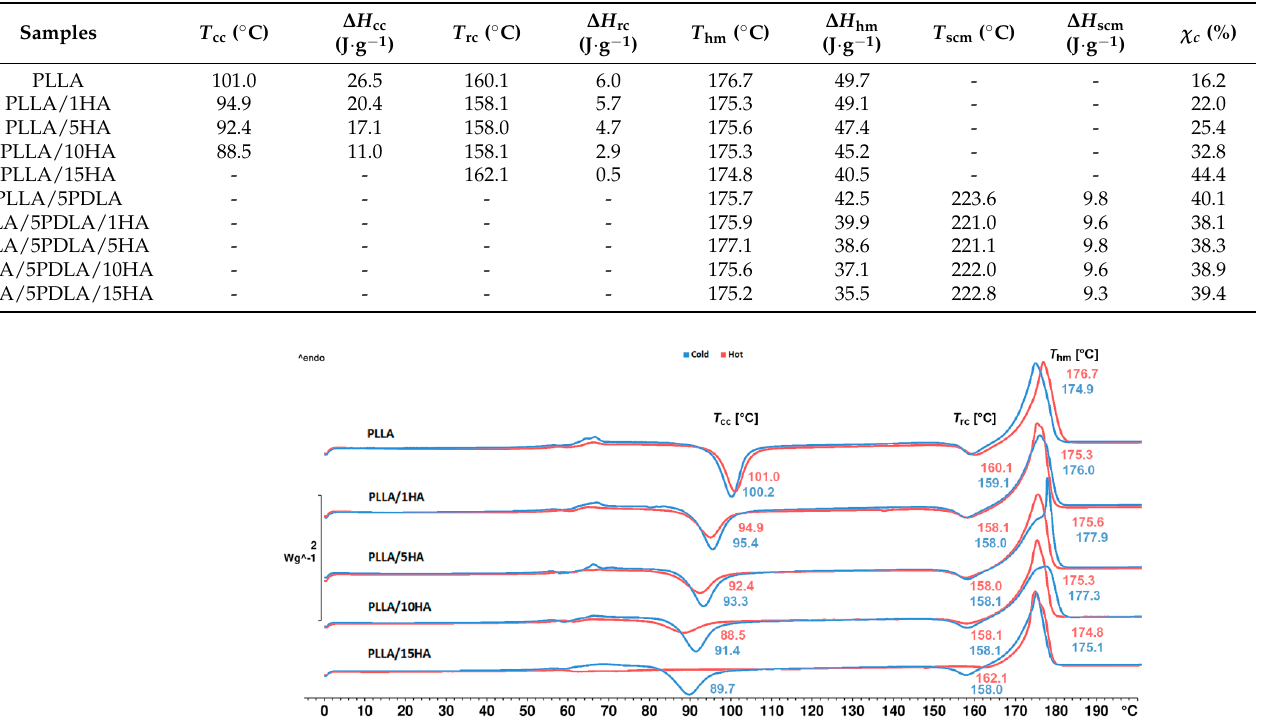
Table 2. Non-isothermal crystallization data of samples from cold mold (50 °C). Table 3. Non-isothermal crystallization data of samples from hot mold (100 ◦ C).